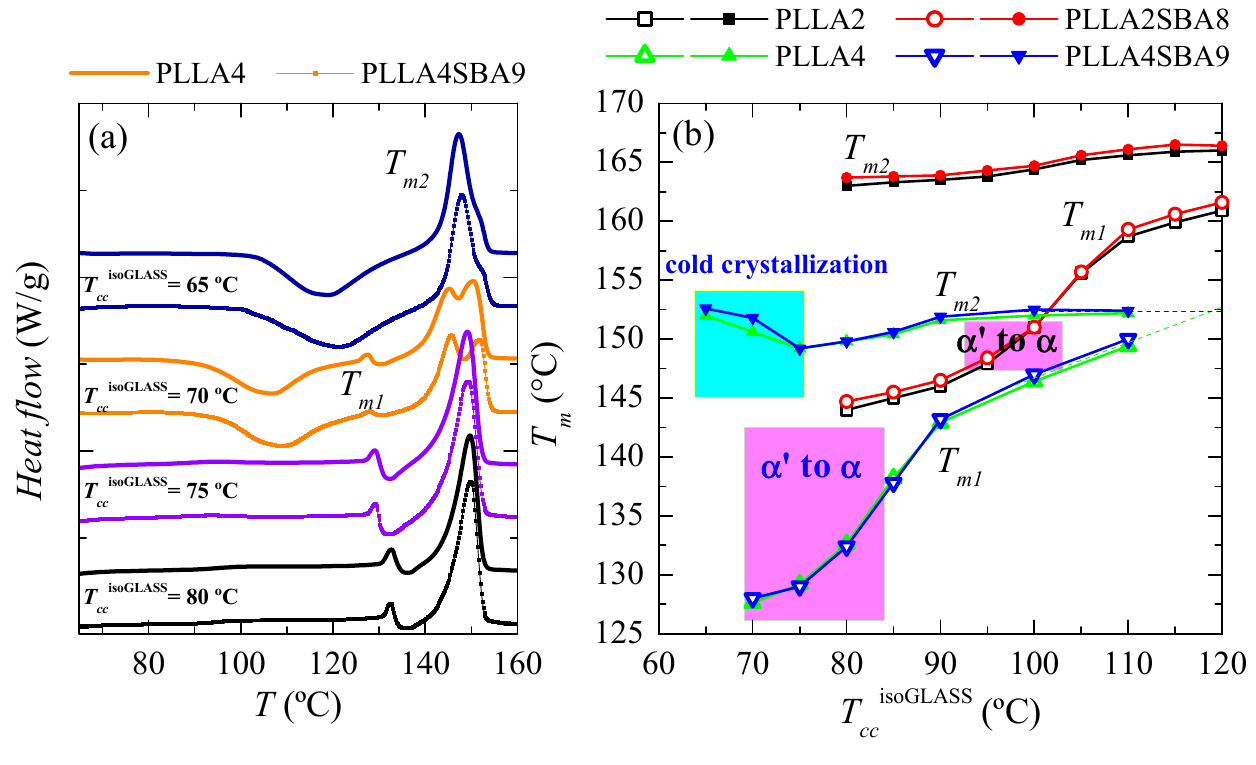
Figure 7. ( a ) Melting behavior as a function of the temperature of isothermal crystallization from the glass, T cc isothermGLASS , for long-time in pristine PLLA4 and its composite PLLA4SBA9. ( b ) Variation of T m 1 and T m 2 on T cc isoGLASS for PLLA2, PLLA4, PLLA2SBA8 and PLLA4SBA9. DSC curves for PLLA4 and PLLA4SBA9 crystallized from the glass at 65 ◦ C exhibit two clear thermal transitions: an extra cold crystallization and a further melting process. The appearance of the dynamic cold crystallization on the heating means that these two materials were not able to finish their ordering from the glassy state by staying for 8